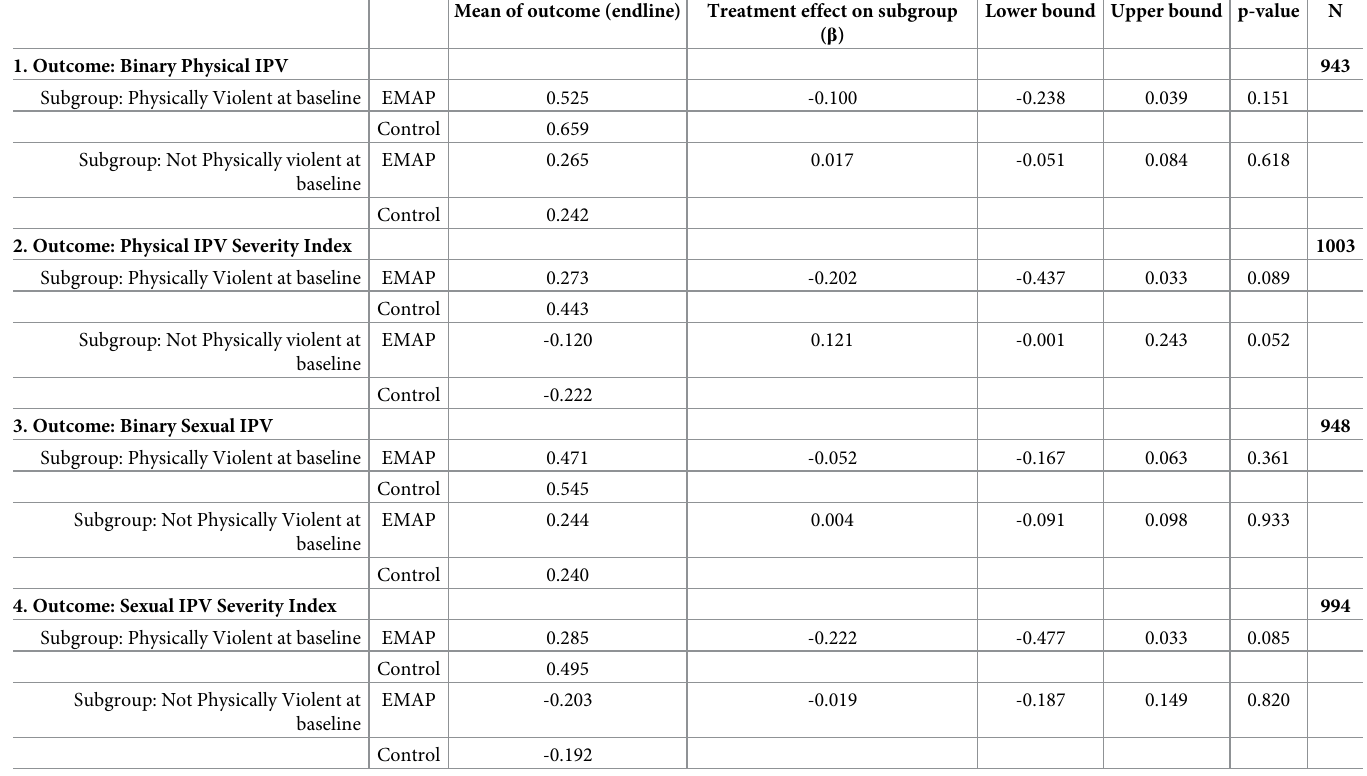
Table 4. Effects of EMAP on experience of IPV by subgroups of physical IPV experience at